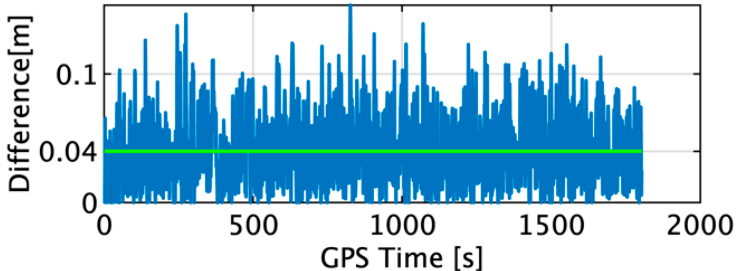
Figure 6. Difference in the horizontal positions estimated by the TG and IGG.